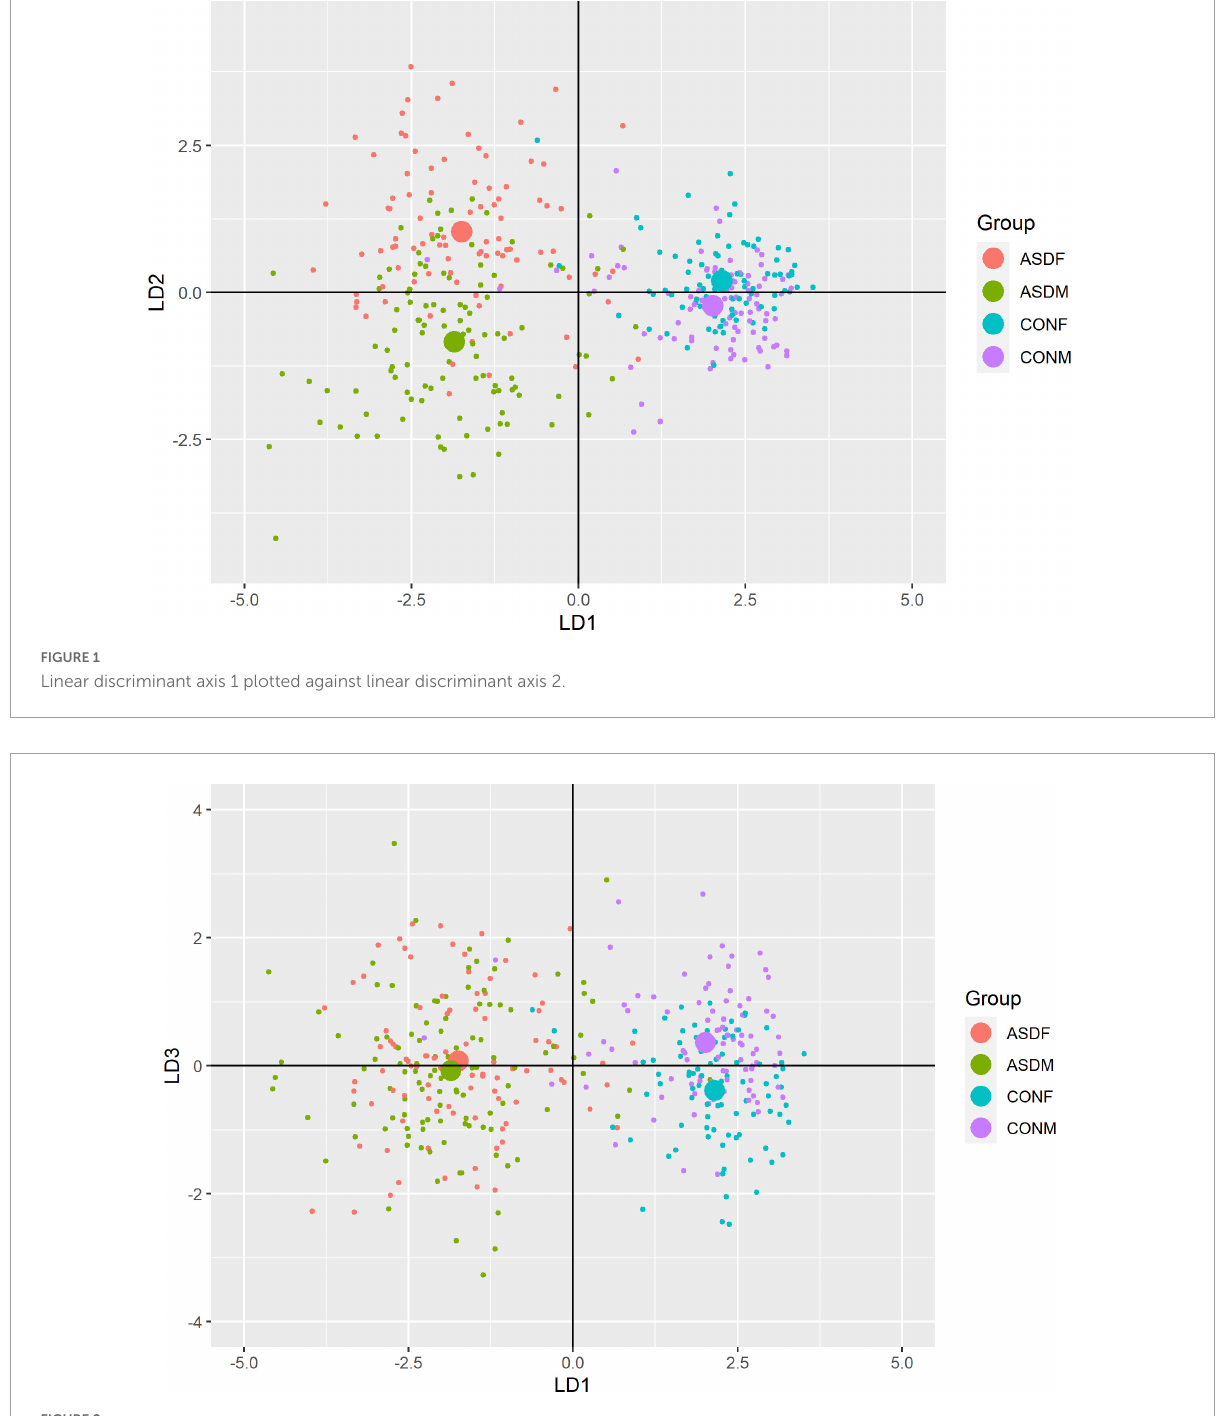
FIGURE2 Linear discriminant axis 1 plotted against linear discriminant axis